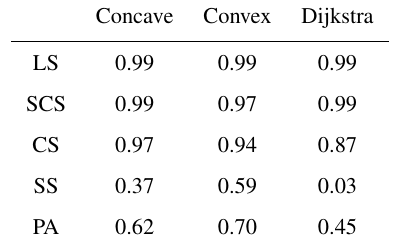
Table 2. Map quality calculated based on introduced quality